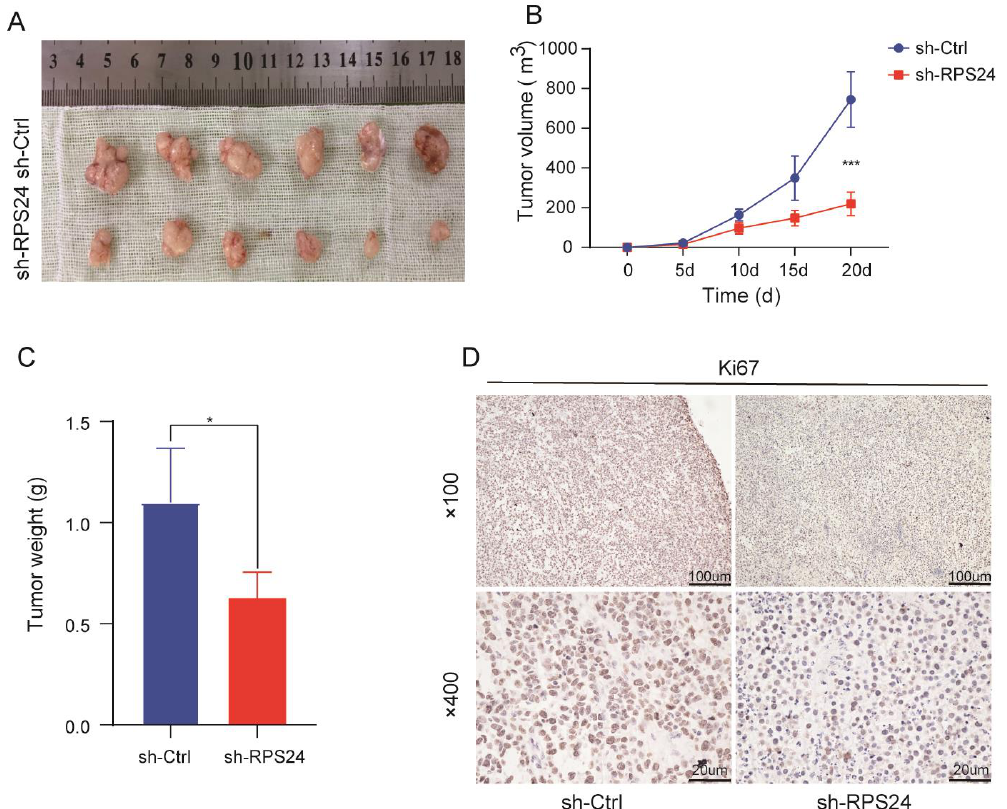
Figure 11. Knockdown of RPS24 reduced tumor growth in mice. Subcutaneous tumor samples ( A ), tumor growth curves ( B ), and tumor weight ( C ) of the sh-RPS24 group and the sh-Ctrl group after the transfected HCCLM3 cells were inoculated in SCID mice for 20 days are presented. ( D ) Immunohistochemical staining of the Ki67 levels in the tumor tissues was performed on both groups. * p < 0.05; *** p < 0.001.